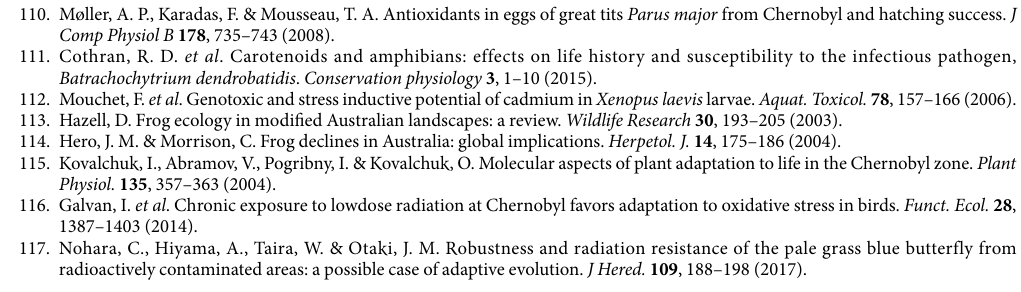
table. T.L. performed the skeletochronology analysis. J.M.B. and K.B. have calculated the total individual dose rate. K.J.M. performed the carotenoid analyses. M.G. wrote the first version of the paper, and M.G. and J.M.B. finalized the manuscript. All authors commented on the